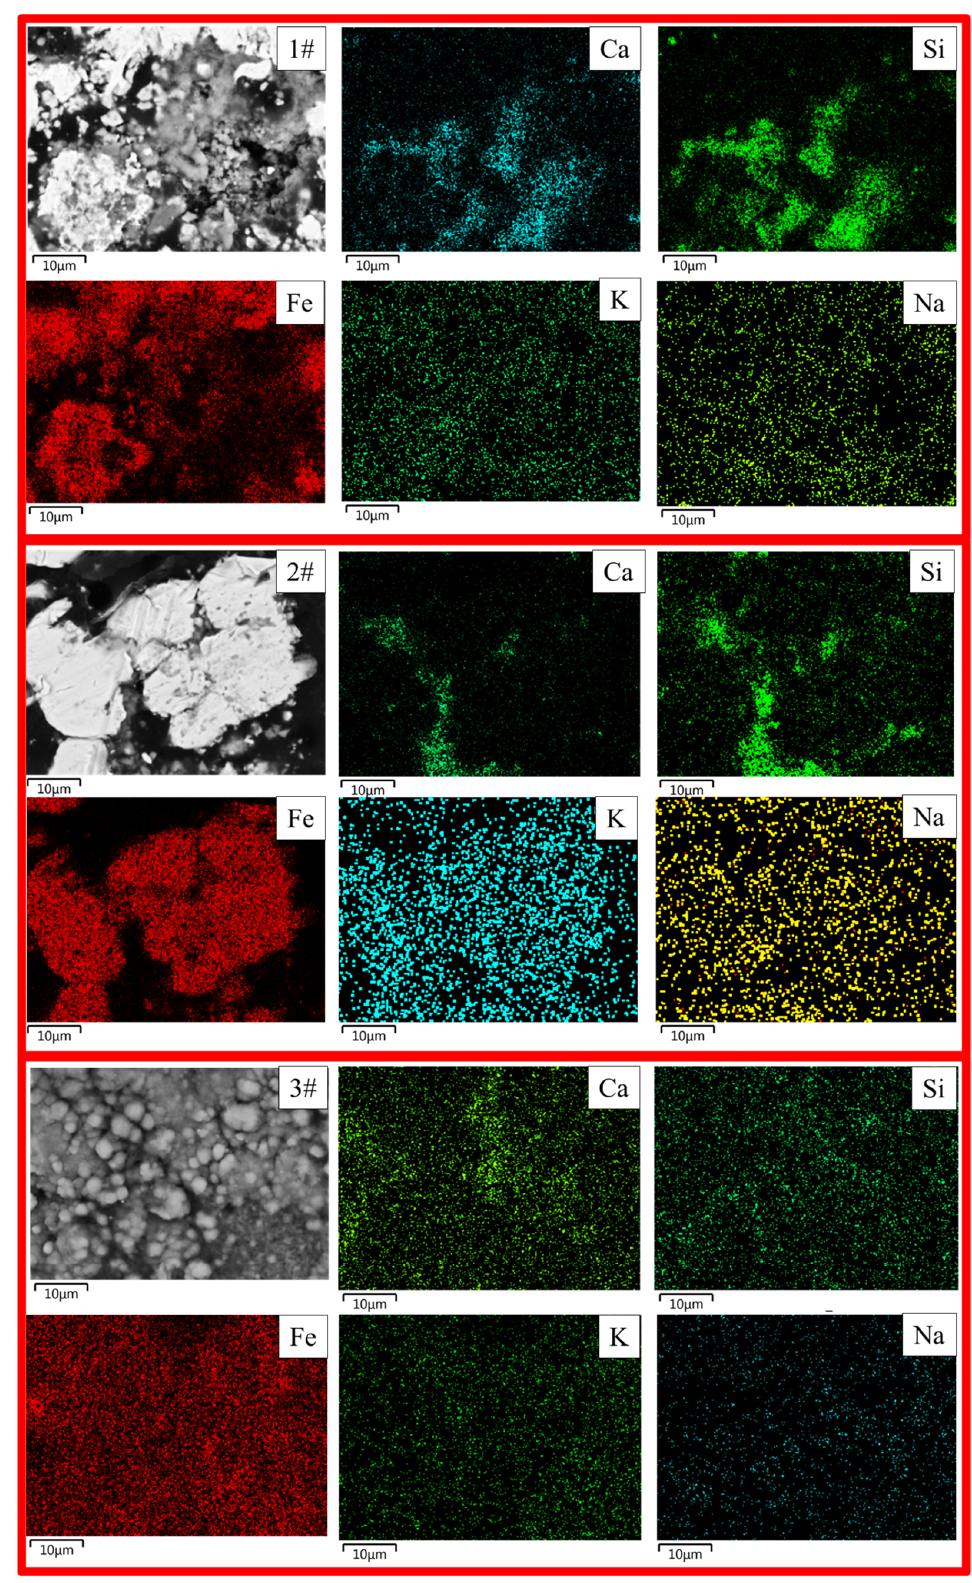
Figure 14. Energy-dispersive spectrum of the third reduction stage of iron oxides with different basicities.